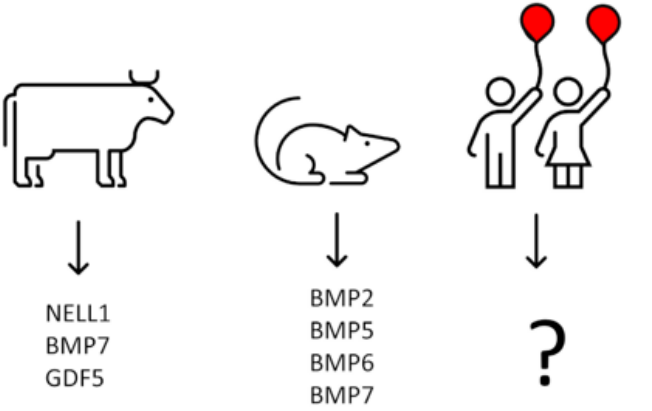
Figure 4. Profile of growth factors acting during physiological bone formation seems to be species